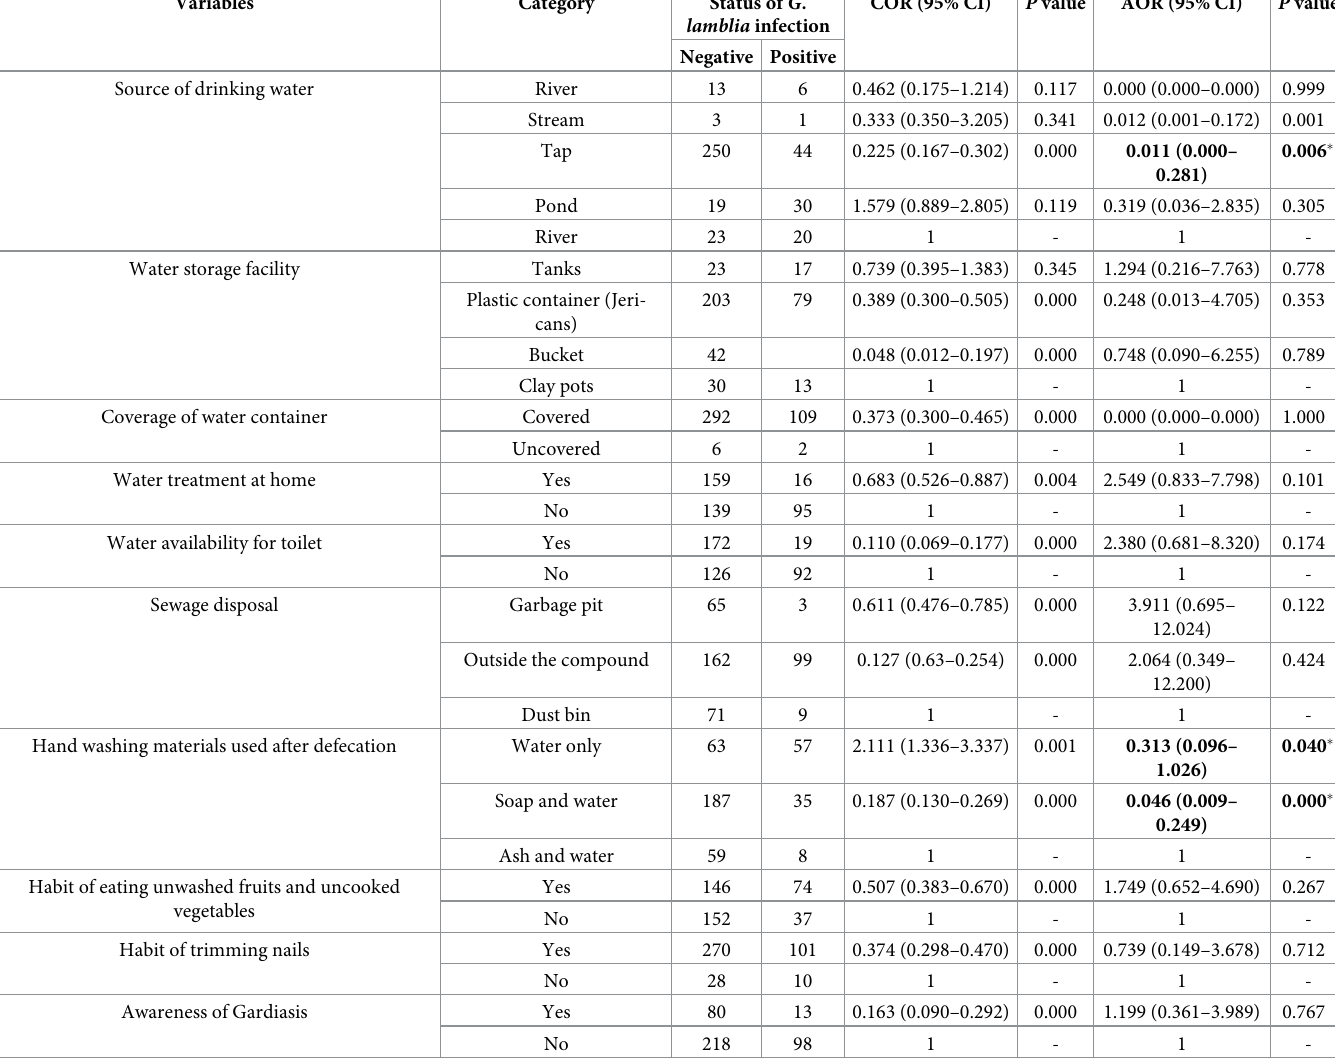
Table 5. Bivariate and multivariate analysis of behavioral and environmental factors of G . lamblia infections from government elementary school students of Lok Abaya town, Sidama zone, SNNPR, Ethiopia.